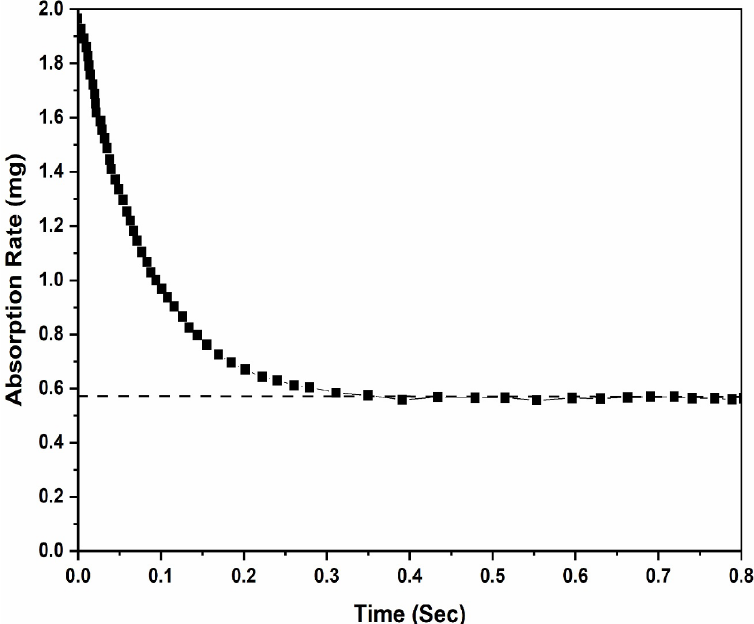
Figure 9. Response of the Dermis Layer.